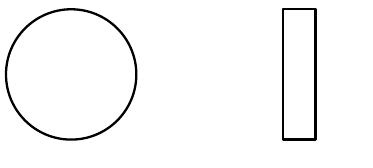
Figure 2. Model elements of Petri